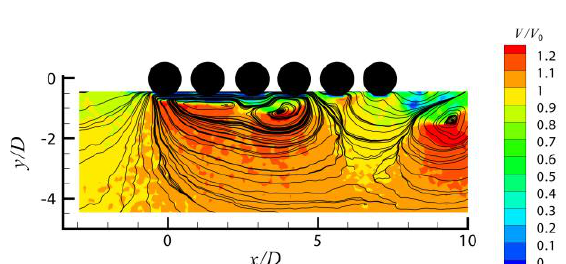
Fig. 7. Normalized velocity magnitude contour plot at first time step obtained for lateral